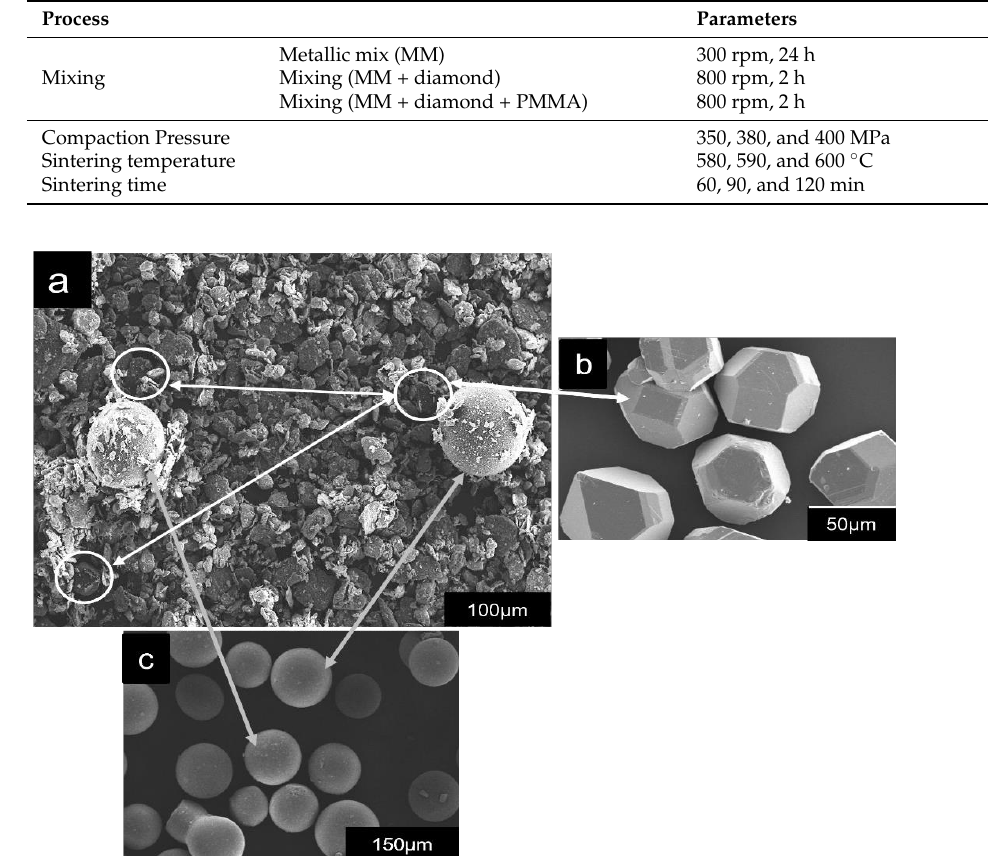
Figure 1. SEM micrography of ( a ) composite powder mix, ( b ) Ti-coated diamond particles, and ( c ) PMMA particles. ( c ) PMMA